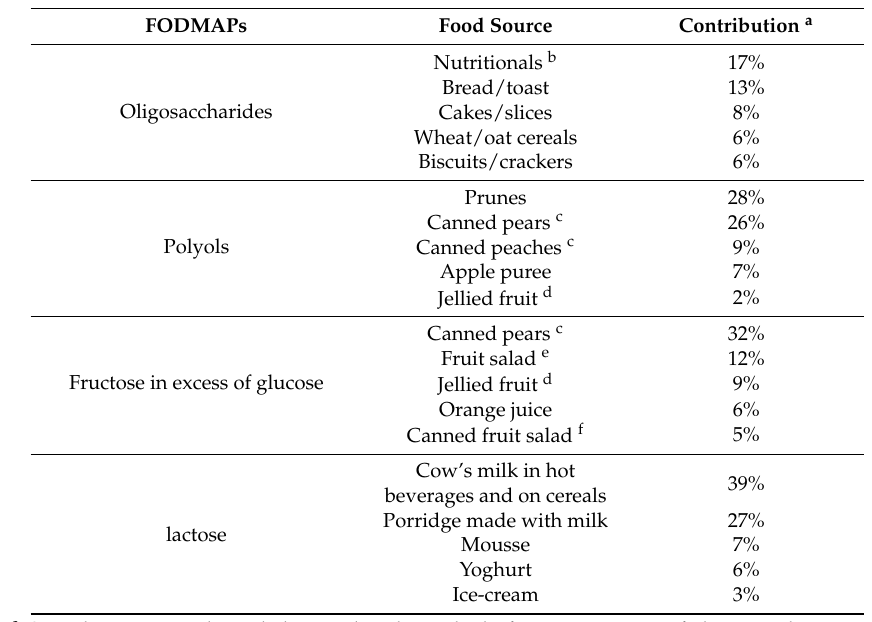
Table 5. Major food sources of FODMAPs consumed by the 54 participants.